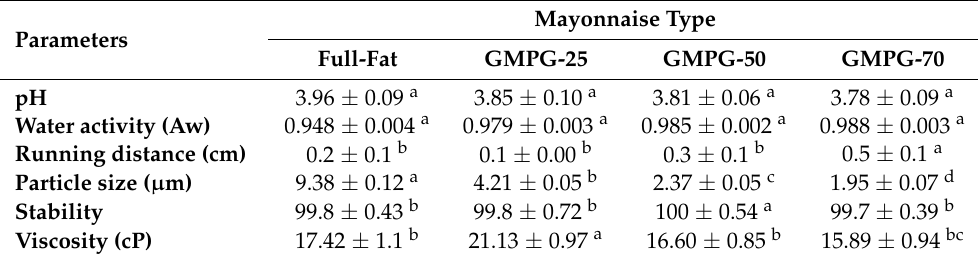
Table 4. pH, water activity (aw), running distance, particle size, viscosity, and emulsion stability of full-fat mayonnaises and mayonnaise with the replacement of oil by Gurma melon pulp gel (GMPG).